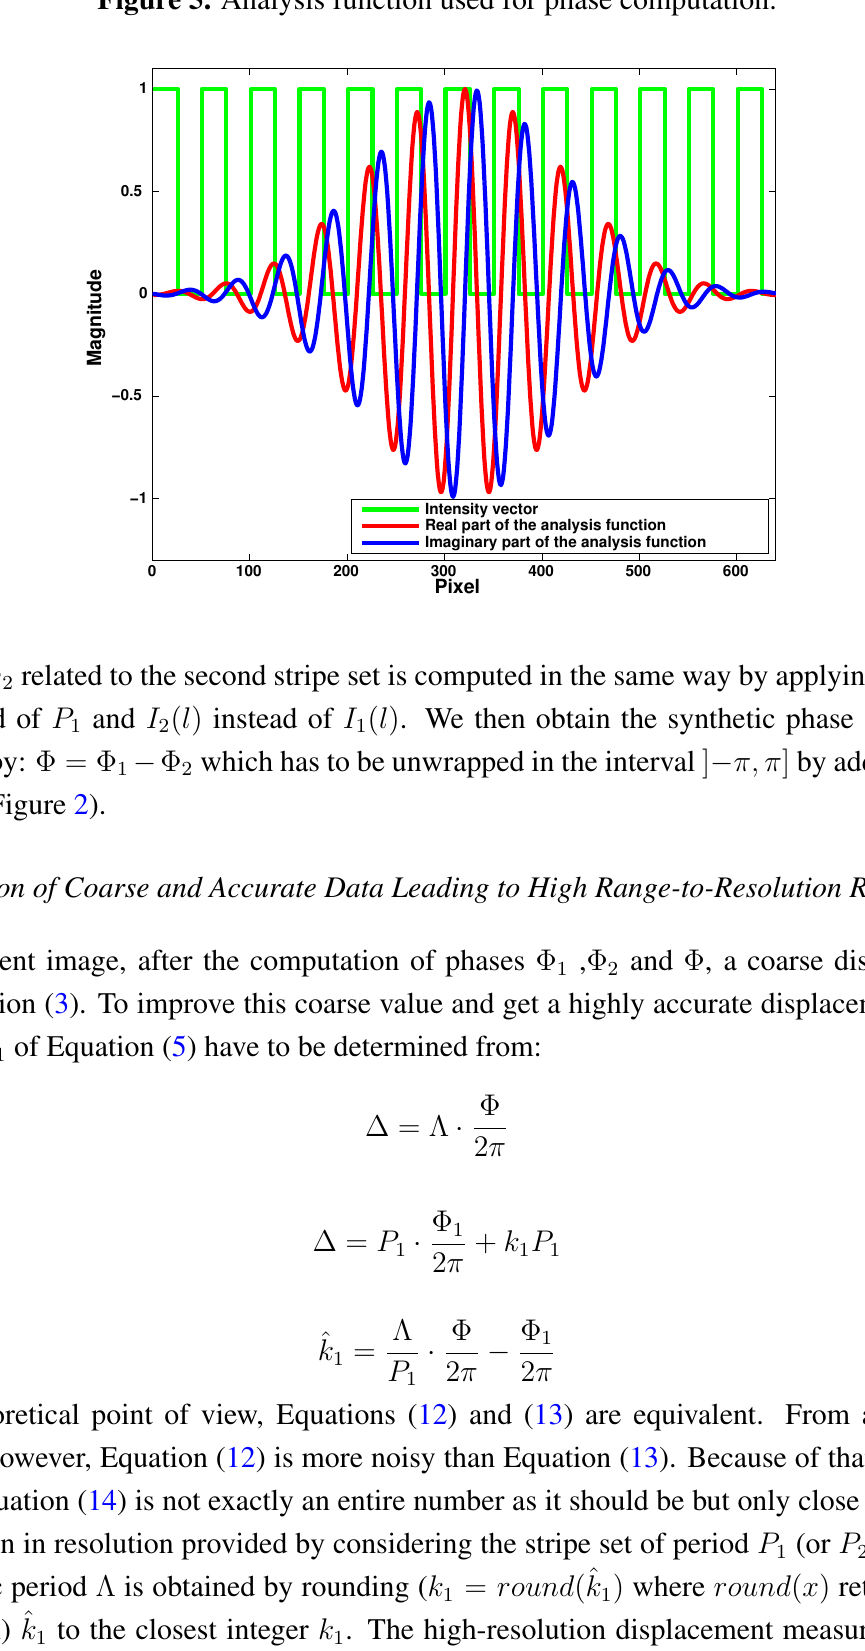
Figure 5. Analysis function used for phase